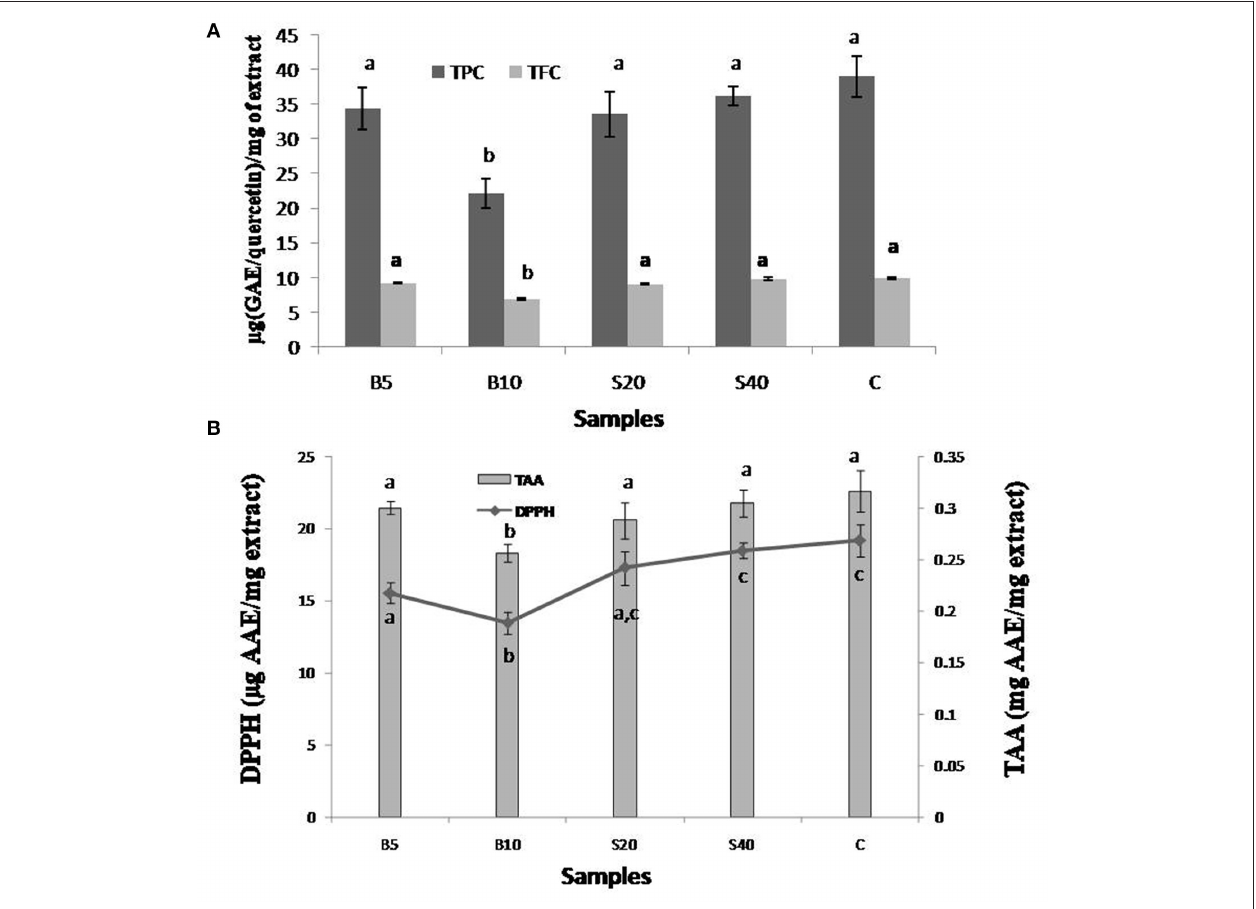
FIGURE 3 | Effects of different cooking methods (steaming and boiling) on (A) phenolic ( µ g GAE/mg of extract) and flavonoid contents ( µ g QE/mg of extract) and (B) DPPH scavenging ( µ g AAE/mg of extract) and total antioxidant activity (mg AAE/mg of extract). TPC, total phenolic contents; TFC, total flavonoid contents; GAE, gallic acid equivalent; QE, quercetin equivalent; AAE, ascorbic acid equivalent. Values not sharing common alphabets within the same pattern are significantly different ( p <